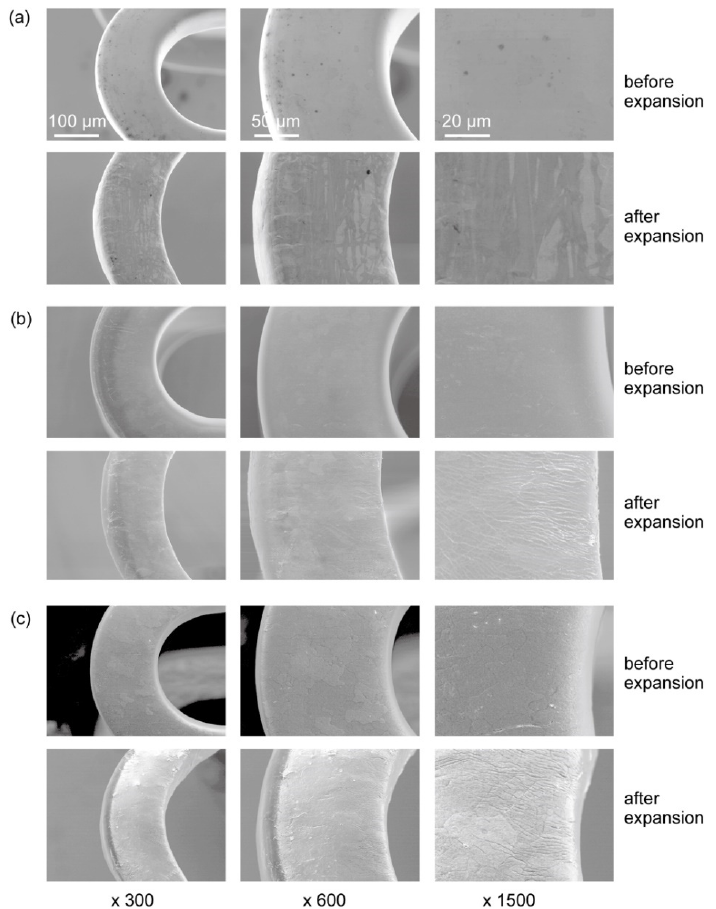
Figure 1. Surface morphology of original Mg alloy stents observed by SEM ( a ), HF-treated stents ( b ), and HF-treated Mg alloy stents coated with parylene C ( c ) before and after balloon expansion at different